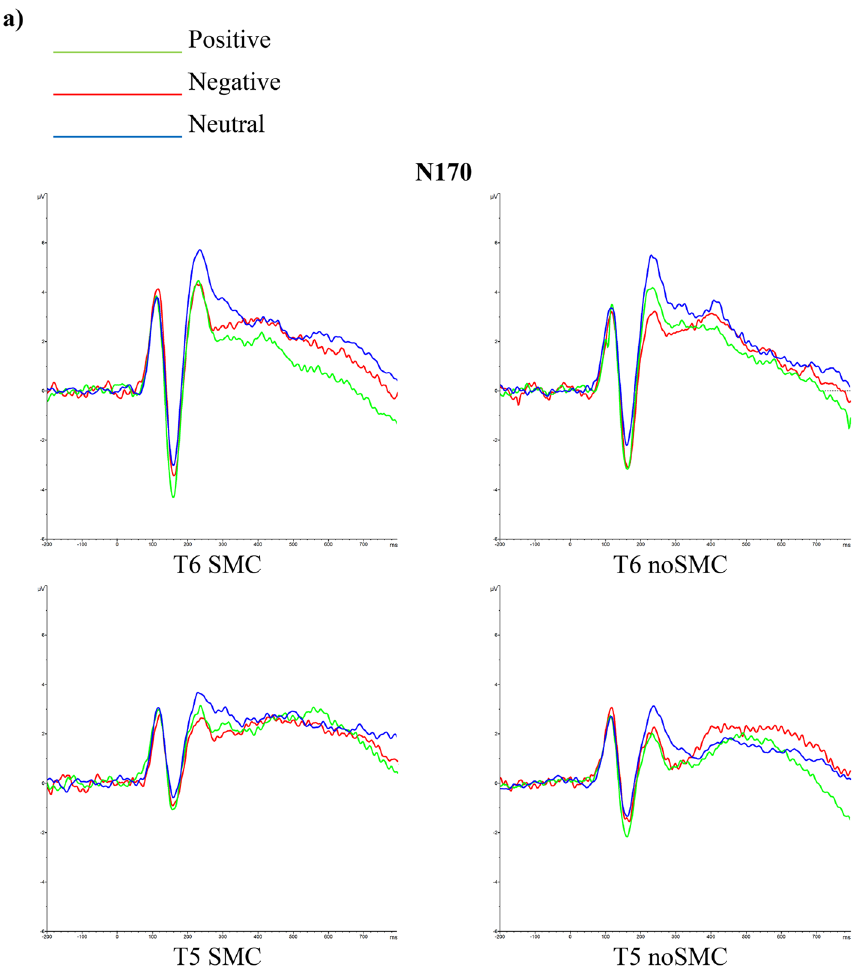
Figure 2. Latencies and amplitudes of N170 and LPP induced by groups and sex. ( a ) Grand average N170 for positive (green), negative (red), and neutral (blue) faces recorded in the right and left hemisphere in young people with and without subjective memory complaints. ( b ). Grand average N170 for positive, negative, and neutral faces recorded in the right and left hemisphere in young women and men. ( c ). Grand average LPP for positive, negative, and neutral faces in young people with and without subjective memory complaints. ( d ). Grand average LPP for positive, negative, and neutral faces recorded in young women and